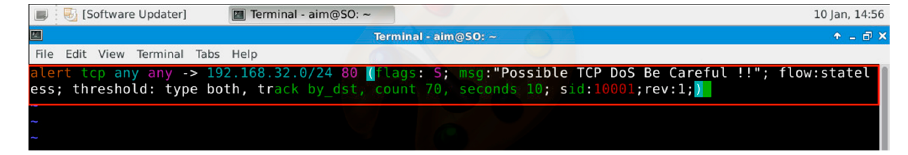
Figure 10. Rule Added for DDoS Detection.